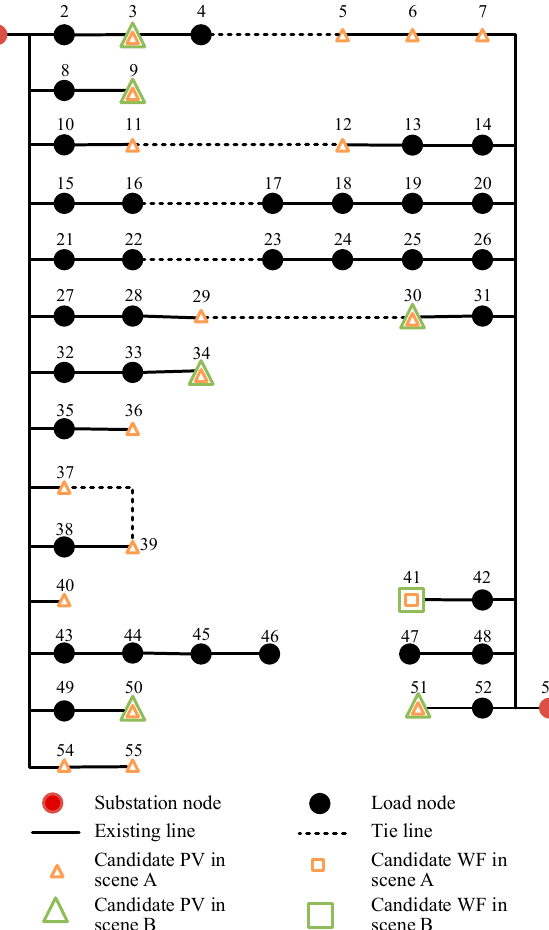
Figure 3. Topology of distribution network. Note: PV = photovoltaic energy; WF = wind farms. To analyze the influence of the number of DG connection nodes on the accommodation capacity and flexibility of the distribution network, two scenes with di ff erent DG connection nodes are set up, as shown in Table 1. Table 1 shows that only node 41 is a WF node, and there are more PV nodes in scene A than in scene B. The maximum accommodation capacity of DG in the distribution network in this area (i.e., the maximum connection capacity of DG) is calculated by the proposed CLPSO algorithm and mixed strategy Nash equilibrium. The basic parameters of the CLPSO algorithm used in this paper are as follows: the number of particles is set to 30; each acceleration factor is 1.494; the upper and lower limit of inertia weight are set to 0.7 and 0.2, respectively; and the maximum number of iterations is set to